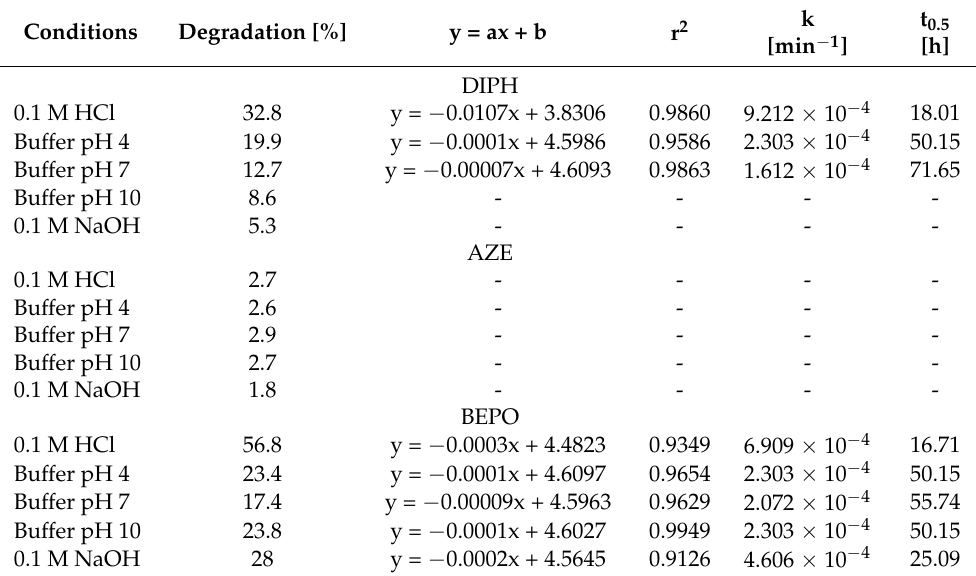
Table 2. Parameters of HPLC-UV methods for the quantitative determination of diphenhydramine (DIPH), azelastine (AZE) and bepotastine (BEPO). Conditions Degradation [%] y = ax + b r 2